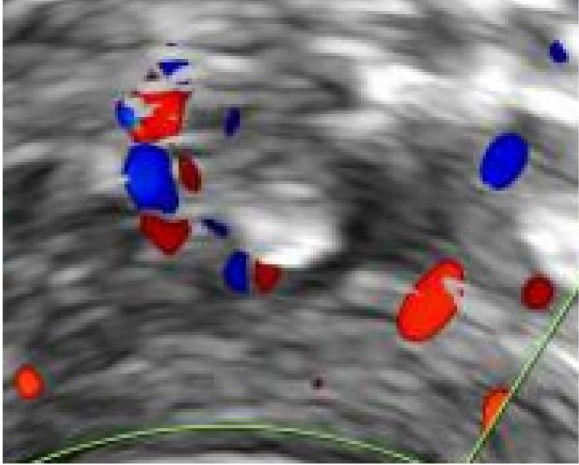
Figure 2. Transvaginal image of uterine vein phlebolith with colour Doppler.